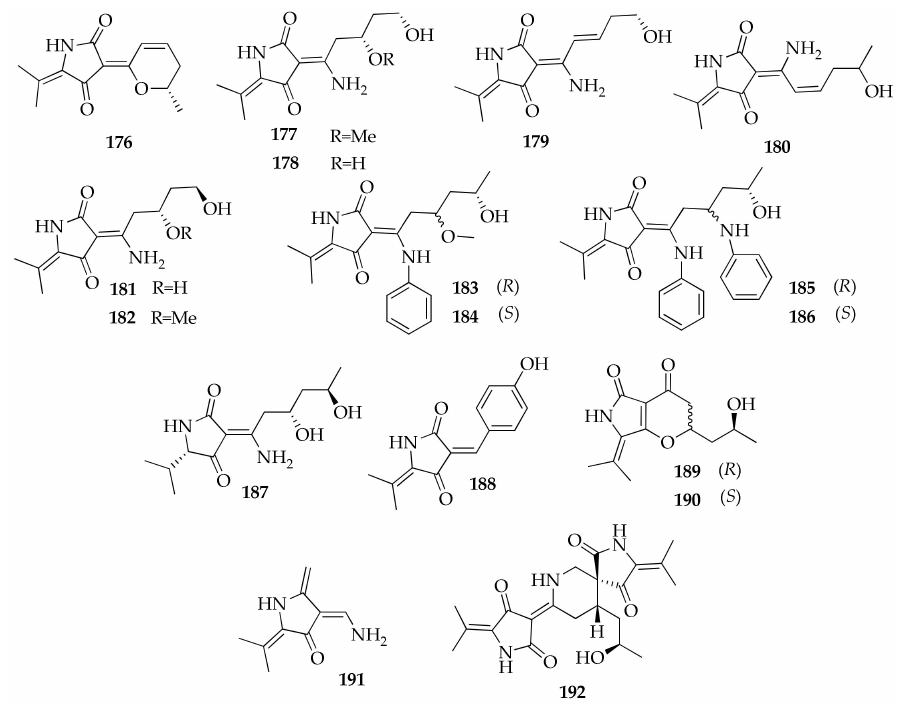
Figure 27. Structures of tetramic